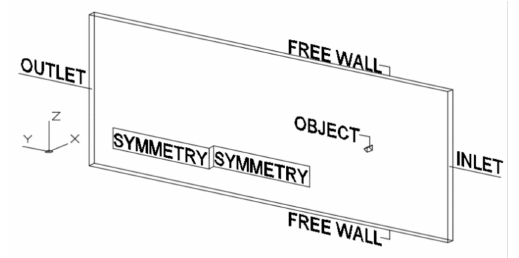
Figure 7. Discrete environment and names of the boundaries used for CFD (computational fluid dynamics) simulation.